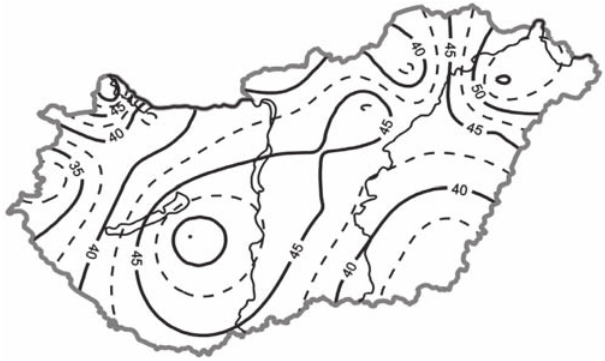
Figure 7 – The mean values of coeffi cients of variation (CV) of the absolute daily maxima of precipitation in summer measured at 16 stations over a period of 1951–2010